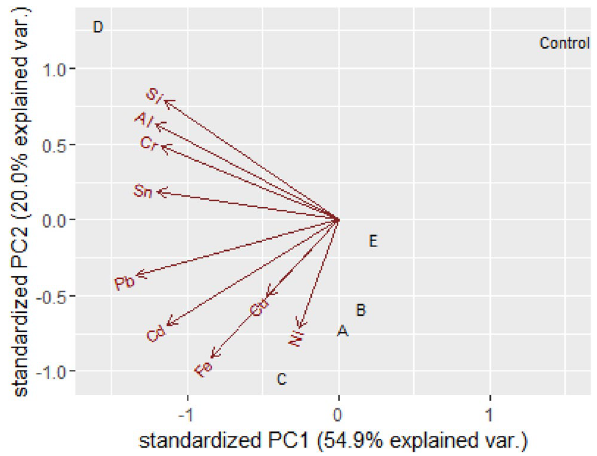
Fig. 7 Principal component analysis for the metals across the loca-